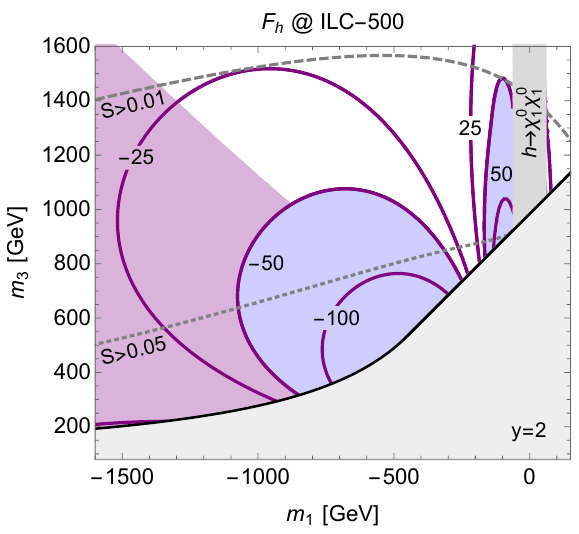
Figure 7 . Form factor Re[ F h ] as a function of m 1 and m 3 for (cid:12)xed y = 2. Purple curves show constant values of F h in percent; in purple areas, (cid:31) 0 is the lightest state. Blue areas can be probed 2 at a future lepton collider with p s = 500 GeV. Dark gray areas are excluded by LHC bounds on the Higgs invisible width. Regions below the dotted (dashed) gray lines are in tension with the S parameter at LEP (can be probed at a